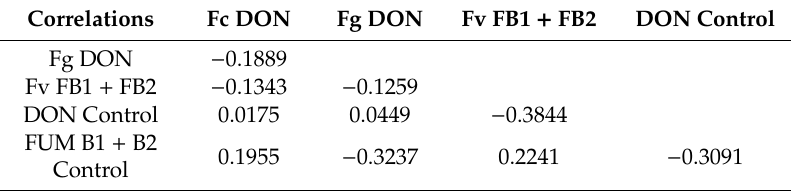
Table 17. SR resistance test for toxins in maize hybrids, n = 10, 2010–2012, correlation between toxin contamination from data Table 16.